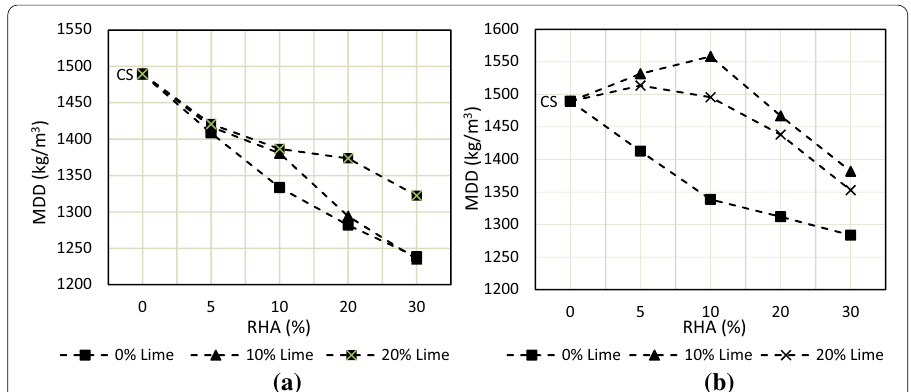
Fig. 3 Effect of RHA and lime mixture on Maximum Dry Density (MDD) a Soon after mixing b 28 days after mixing